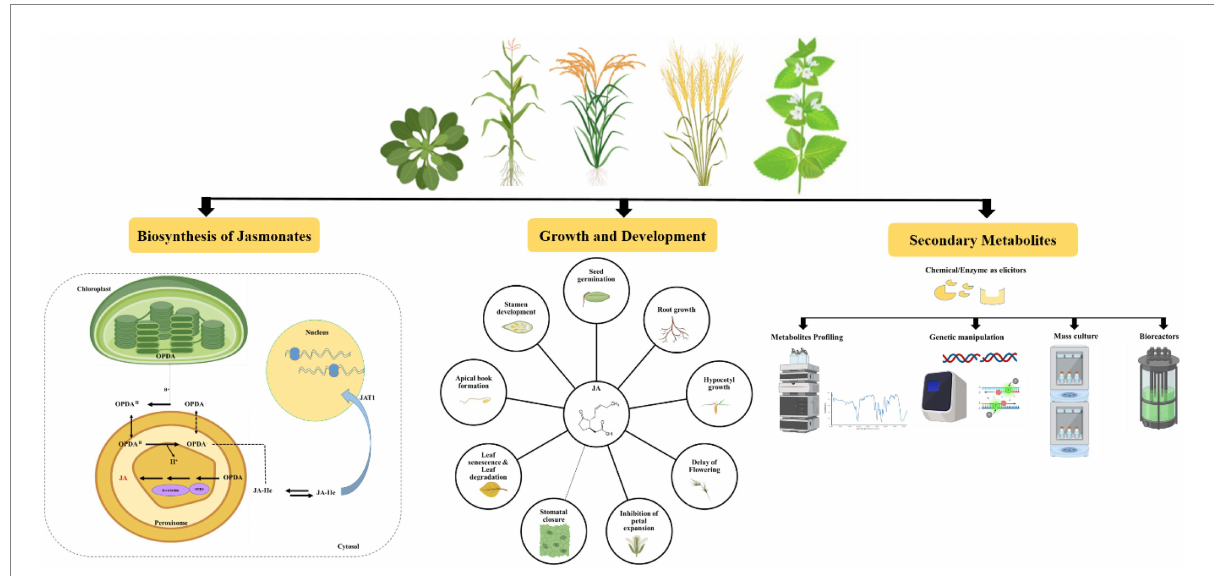
FIGURE 2 Schematic representation of jasmonates biosynthesis, role in growth and development and elicitation of secondary